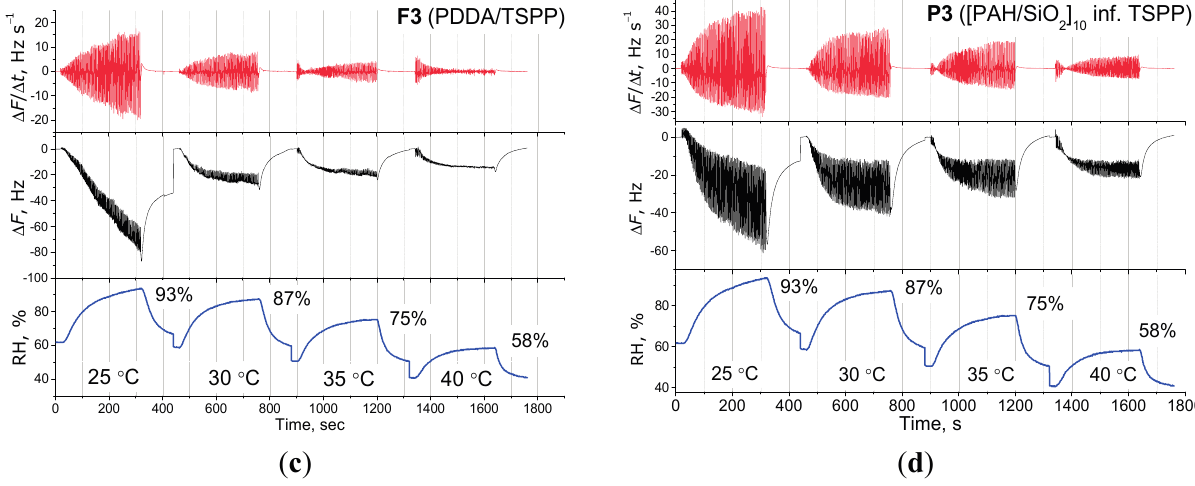
Figure 5. Influence of the measurement temperature on the QCM response on respiration. ( a ) Frequency shifts; and ( b ) their respective derivatives on 6 different types of films; and ( c ) typical flat-type film response ([PDDA/TSPP] 10 as example); and ( d ) typical porous